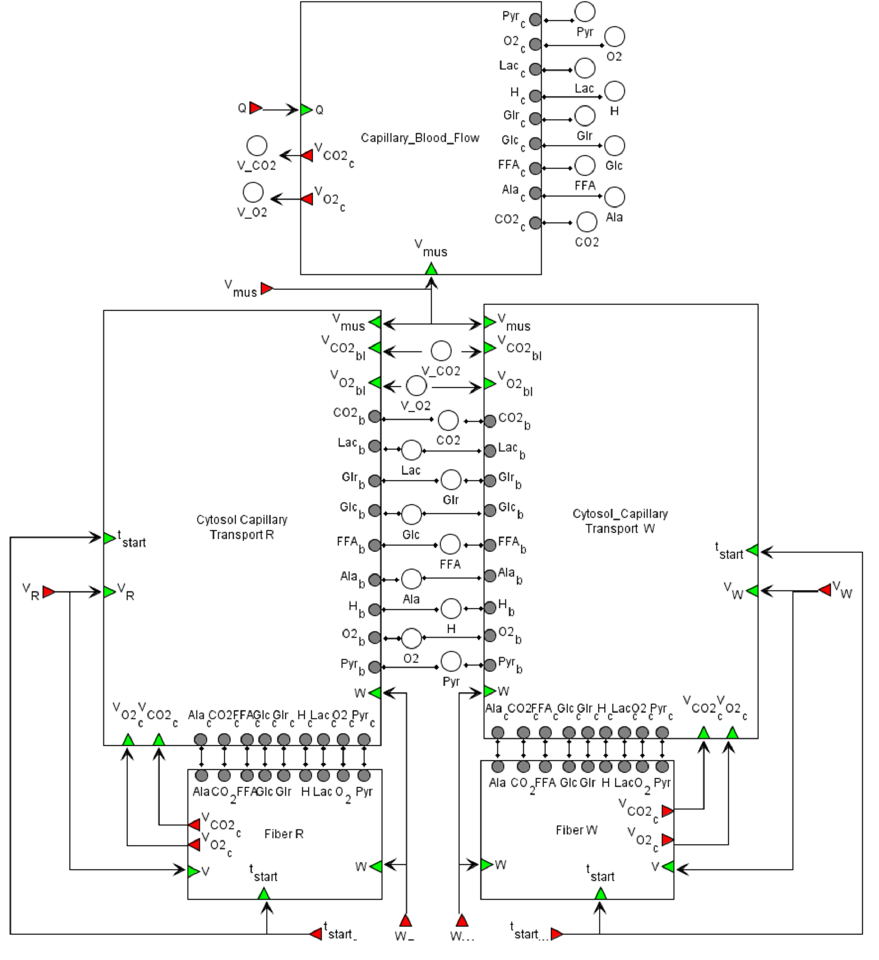
Figure 5. The modular representation of the integrated model at the physiological level. The model comprises five modules: “Capillary_Blood_Flow” to describe flow processes in the blood; “Cytosol_Capillary Transport R” and “Cytosol_Capillary Transport W” modules representing transport reactions between capillary blood and the muscle tissue, “Fiber R” and “Fiber W” modules where metabolic, signaling, and gene expression regulation processes are considered. All details for each submodule and zoomed-in subfigures are in the Supplementary Material.